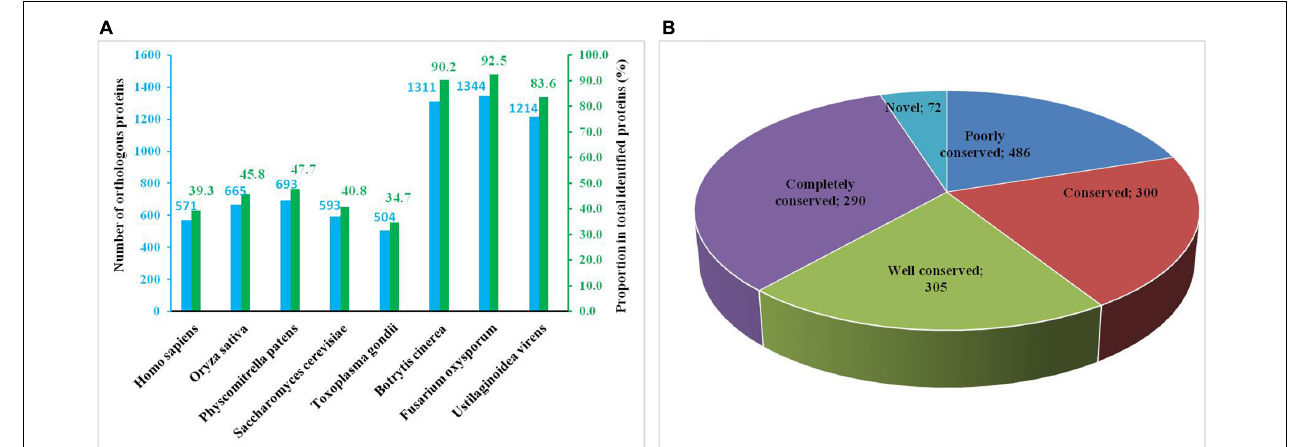
FIGURE 2 | Conserved analysis of Khib proteins in different species. (A) Number of orthologous Khib proteins in five organisms with reported 2-hydroxyisobutyrylomes. (B) A pie chart of conservation of Khib proteins in five organisms. Grouping was performed as follows: Completely conserved, 5 orthologs; Well conserved, 4 orthologs; Conserved, 3 orthologs; Poorly conserved, 1 to 2 orthologs; Novel, 0 orthologs.